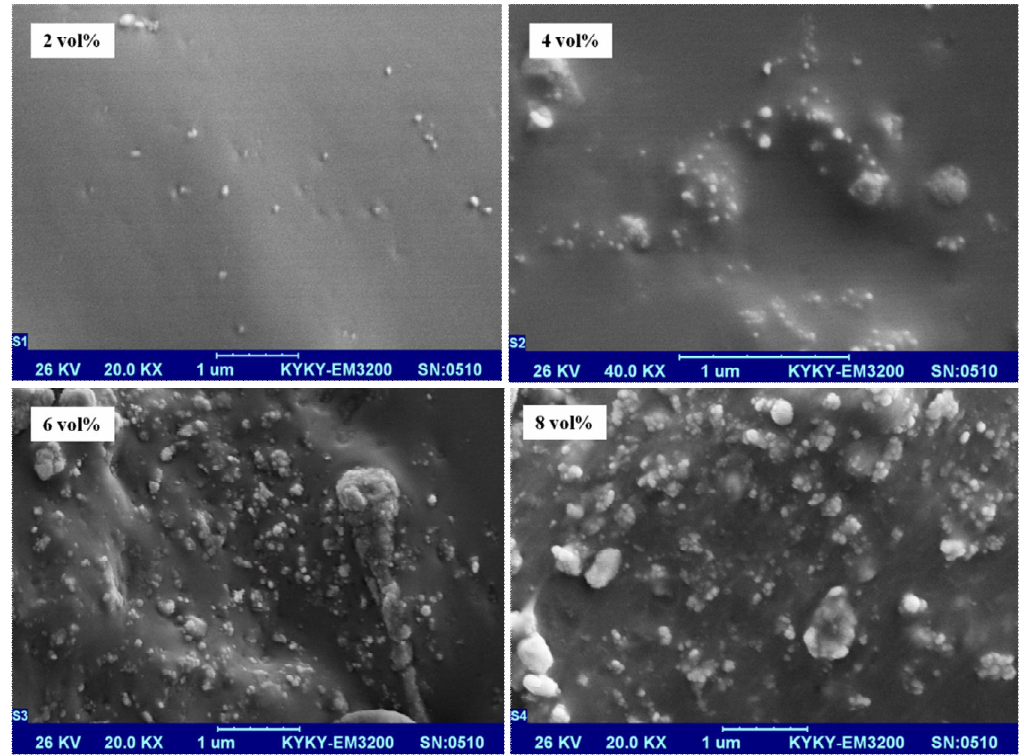
Fig. 5. The SEM images of AgNP@EPR composites with 2, 4, 6 and 8 vol% of